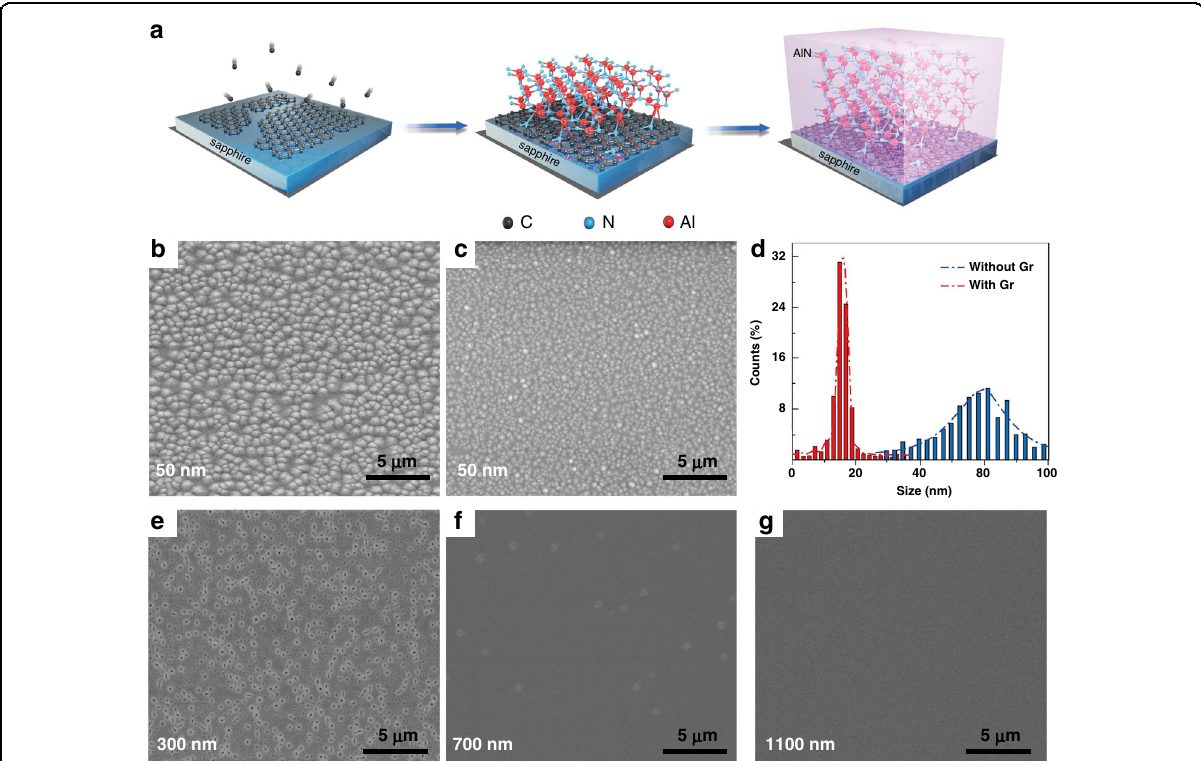
Fig. 2 Morphology characterization of AlN nucleation and fi lm growth on sapphire substrate with and without Gr buffer layer. a Schematic diagram of the key steps involved in the growth of high-quality AlN fi lms on N 2 -plasma-treated Gr/sapphire substrate. b , c SEM images of AlN nucleation on the sapphire substrate ( b ) without and ( c ) with Gr. d Size distribution analysis of AlN nucleation on sapphire and Gr/sapphire substrate. e – g SEM images of AlN interrupted growth on Gr-buffered sapphire with thicknesses of ( e ) 300 nm, ( f ) 700 nm, and ( g ) 1100